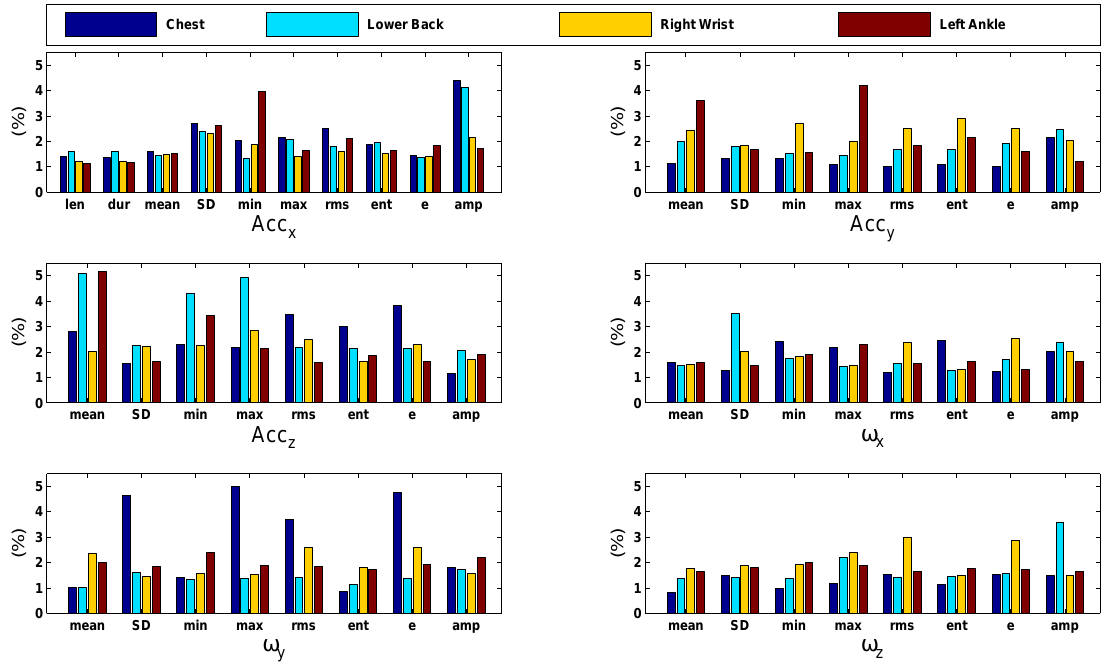
Figure 6. Bar graphs of the features’ importance computed during gender classification using the 10-fold cross-validation strategy. The graphs present a comparison of the importance of each feature (in %) with respect to different sensor positions. In general, all features are significantly contributing in the classification